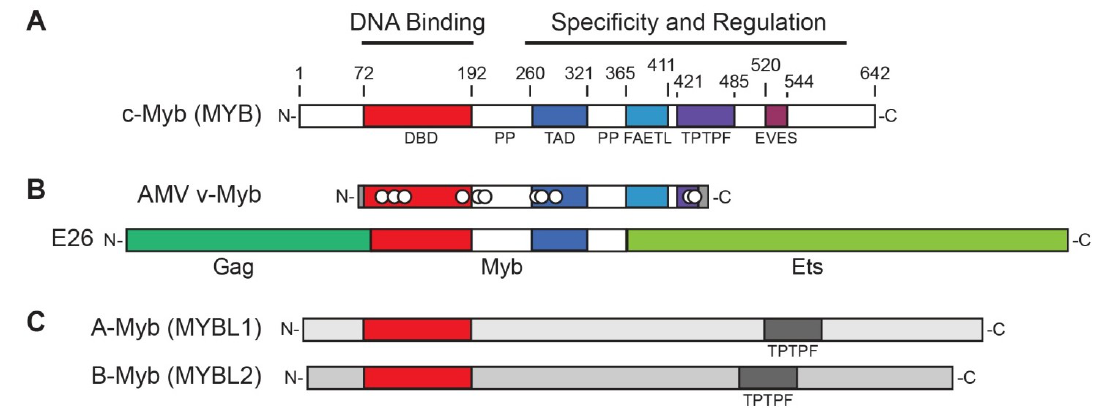
Figure 1. Myb Protein Structures and Conserved Domains. ( A ) Conserved domains in c-Myb. The structure of the c-Myb protein is diagrammed, with N-terminus at left and C-terminus at right. Domains that are most conserved in human, mouse and chicken proteins are shaded and amino acid residues are numbered above the diagram, including the DNA binding domain (red) near the N-terminus. Labels below the diagram indicate conserved domains (DBD, TAD, FAETL, TPTPF and EVES) and proline-rich regions (PP) that are discussed in the text; ( B ) Structures of the oncogenic v-Myb proteins encoded by Avian Myeloblastosis Virus (AMV) and E26 virus. The AMV protein has 6 amino acids derived from the retroviral Gag protein fused to amino acids 72-442 of c-Myb, fused to 13 novel non-Myb amino acids at the C-terminus (shaded gray). It also has eleven point mutations that distinguish it from c-Myb, indicated by white dots. The E26 protein is a Gag-Myb-Ets fusion, as indicated (the non-Myb regions are shaded dark and light green, respectively); ( C ) Diagrams of the structures of the related A-Myb (MYBL1) and B-Myb (MYBL2) proteins. These proteins are most similar to c-Myb in the conserved DNA binding domains (red) and in the conserved TPTPF domains (gray,